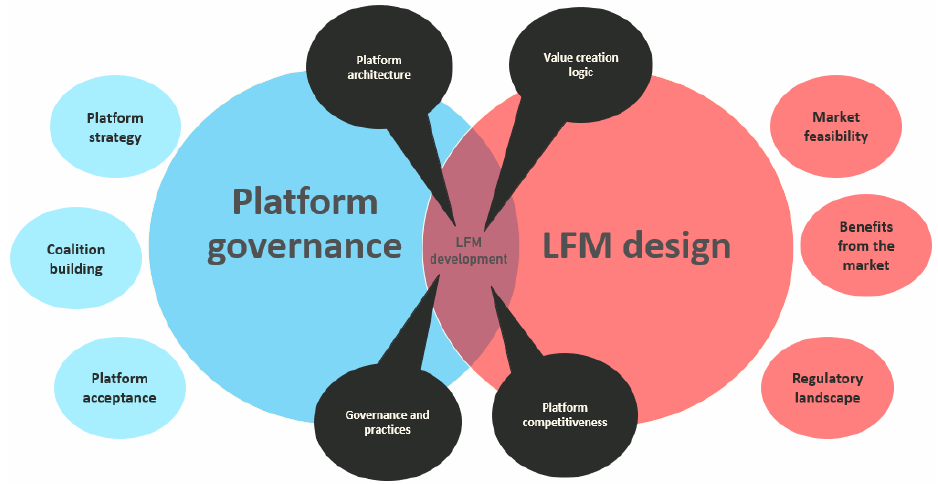
Figure 3. The preliminary theoretical framework: Platform governance and stakeholder influence on local flexibility marketplaces.